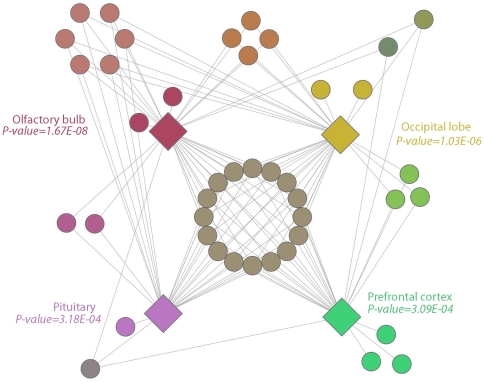
Network analysis of the AutRef84 expression profile.In this visual representation of the network, each group of gene nodes is spatially positioned near the brain region or regions in which the genes are expressed. The color of each group of gene nodes was derived by averaging red, green, and blue values of the colors of the linked brain region nodes.